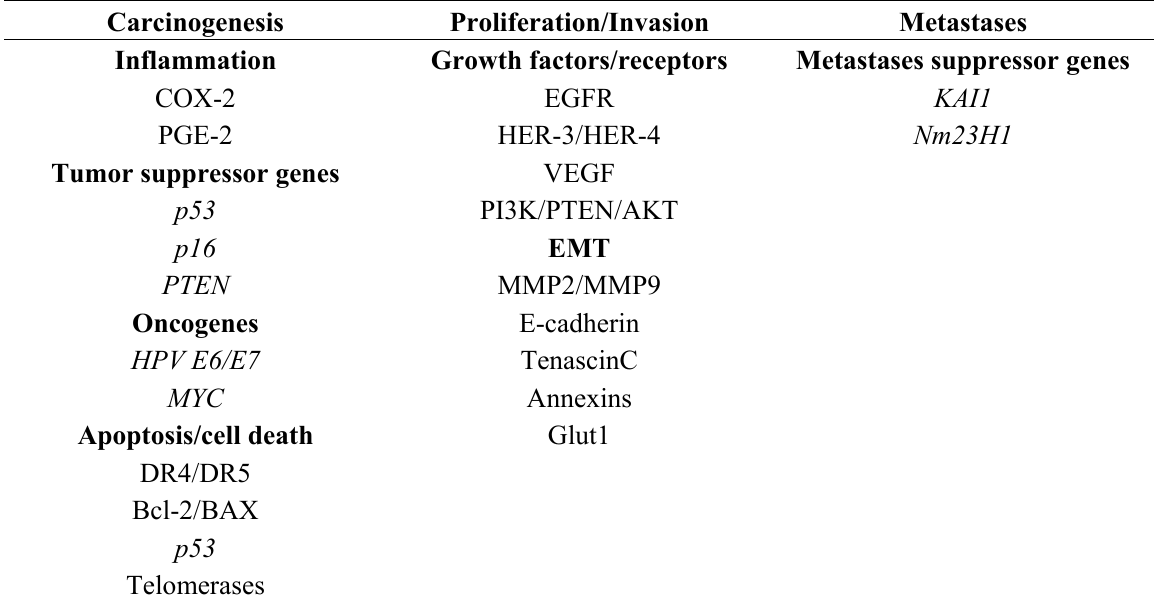
Table 1. Molecular changes reported for penile